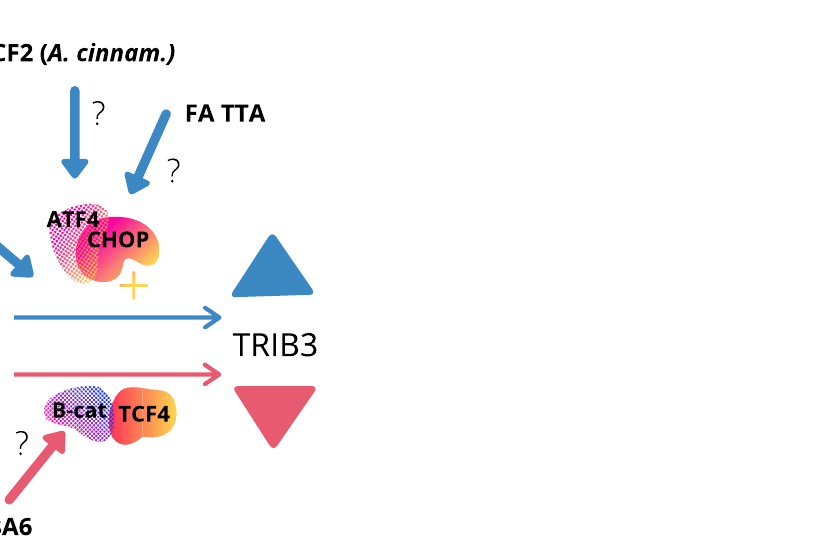
Figure 3. Proposed mechanisms for TRIB3 pharmacological modulation in colorectal cancer. Com- pounds that alter TRIB3 expression based in references [79,85,86,98], are depicted on figure. TRIB3 was upregulated in response to FA-TTA and ACF2 extract treatments, along with CHOP induction. TRIB3 levels were elevated after HY-PDT, in a CHOP-dependent fashion. P2-T3A6 treatment caused disruption of the β -catenin– TRIB3 interaction, leading to decreased TRIB3 levels. Symbols: (cid:78) rep- resents up-regulation (in blue color) and (cid:72) represents down-regulation (in pink color) of TRIB3 . Transcription factors are depicted as random elements from Canva design. FA-TTA, bioactive chem- ical modified fatty acid analog saturated 3-thiatetradecylthioacetic acid; HY-PDT, photosensitizer hypericin and photodynamic therapy; ACF2 is a specific extract from Antrodia cinnamomea , a native Taiwanese rare mushroom; P2-T3A6, fusion peptide.